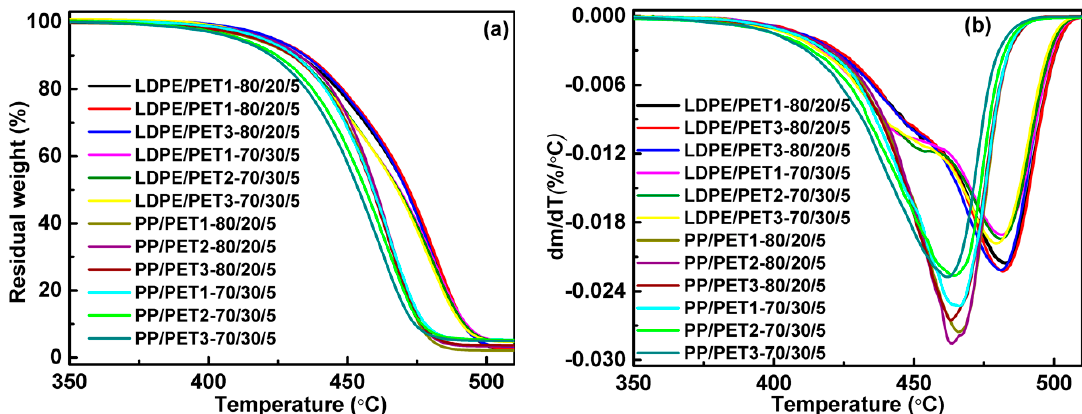
Figure 3. TG ( a ) and DTG ( b ) curves of incompatible polymer blends.